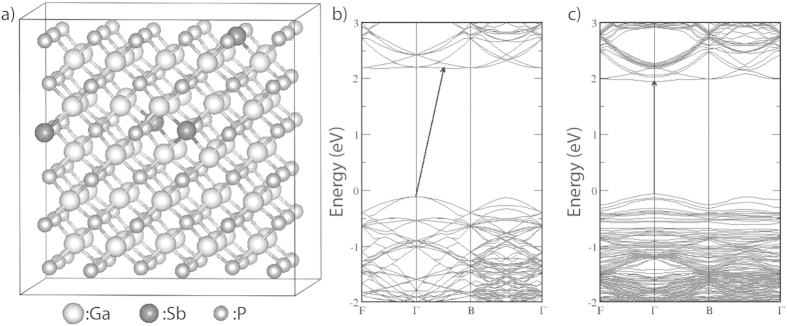
(a) A 216 atom Supercell of GaP0.963Sb0.037 optimized using DFT calculations and a comparison of density of states diagrams for (b) GaP and (c) GaP0.963Sb0.037 showing the direct optical band gap transition with 1.8% Antimony incorporation.